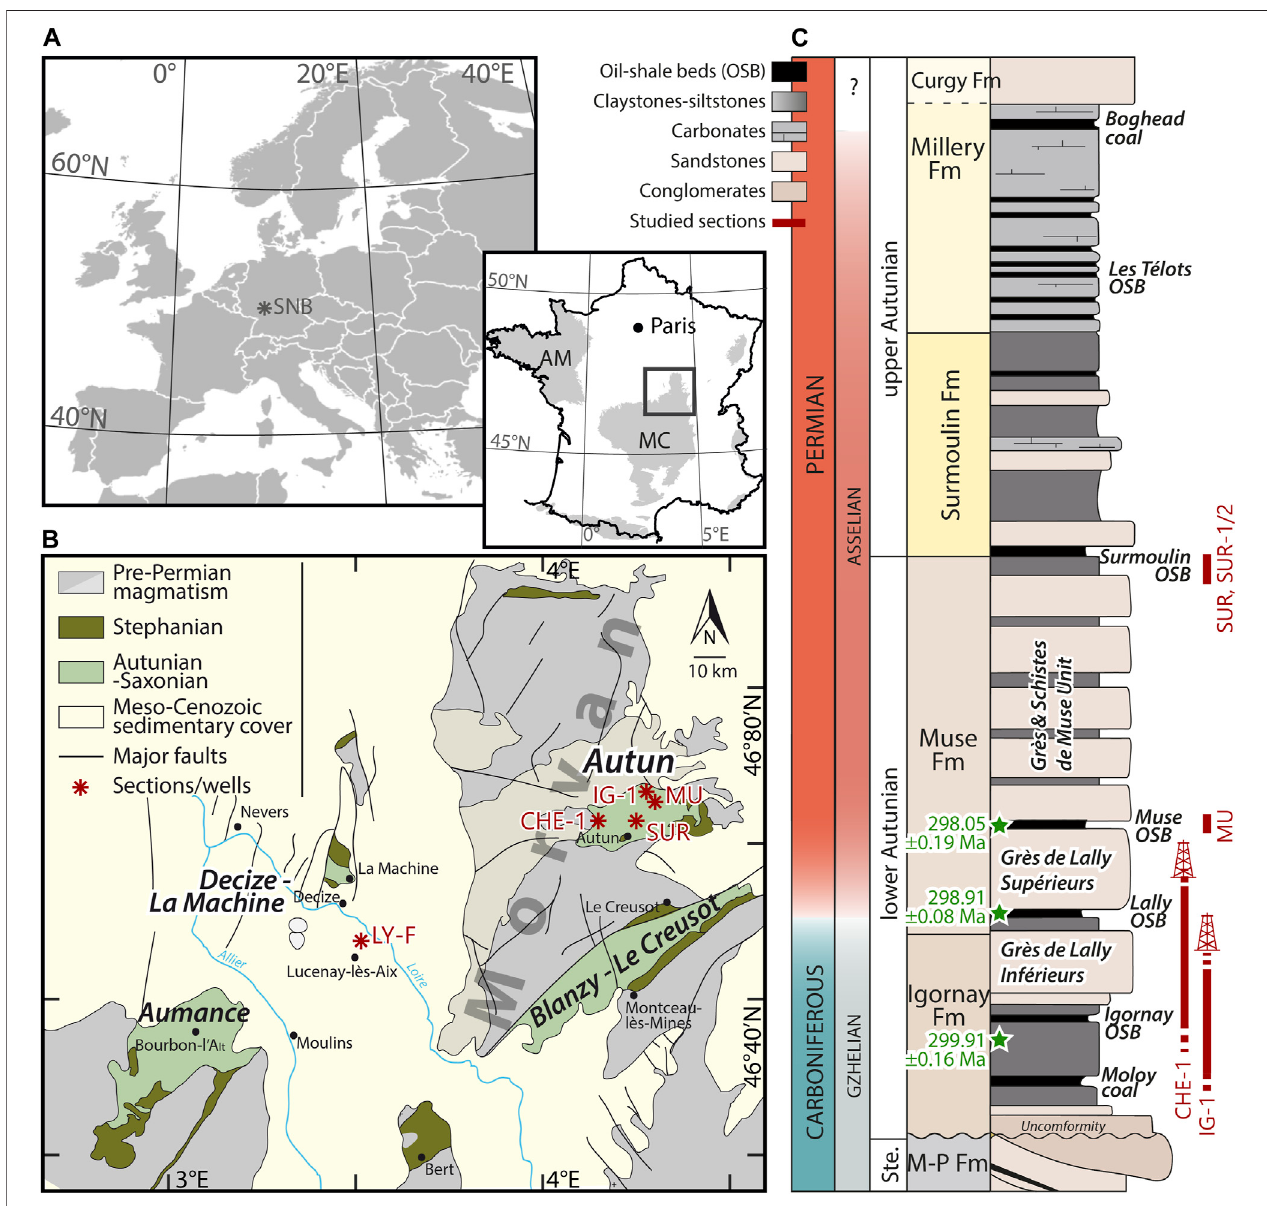
FIGURE 1 | (A) Map of Europe, with a zoom on France where the Variscan remains are displayed in grey. AM, Armorican Massif; MC, Massif Central; SNB, Saar- Nahe Basin. (B) Simpli fi ed map of the north-eastern Massif Central, showing four late Carboniferous to Permian basins, including the Autun and the Decize-La Machine basins described in this study (modi fi ed from Elsass-Damon, 1977). (C) Lithostratigraphic column of the Autun Basin showing the location of the studied wells and sections in the stratigraphy. Fm, Formation; Ste., Stephanian; M-P Fm, Mont-Pelé Fm (modi fi ed from Pellenard et al., 2017).